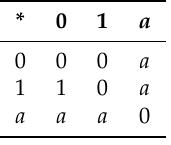
Table 1. Cayley table for the binary operation “ ∗